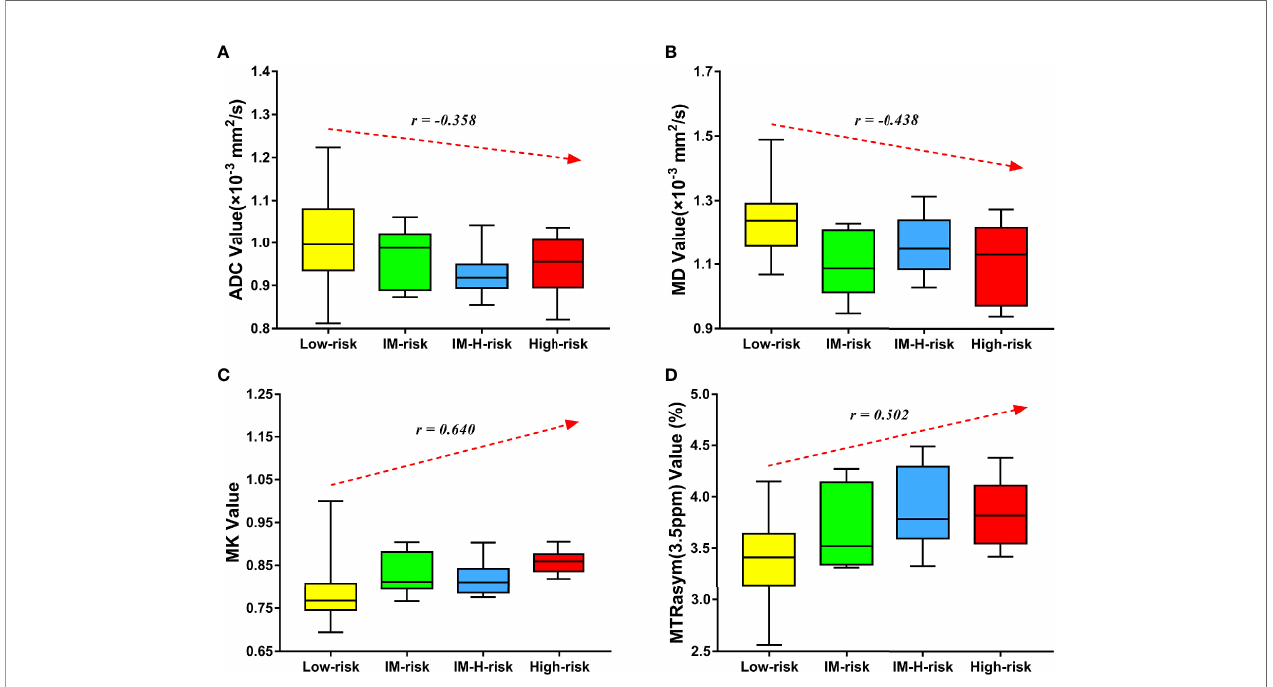
FIGURE 4 | Correlation of various parameters with risk strati fi cation ( LM , intermediate; LM-H , intermediate-high). The apparent diffusion coef fi cient (ADC) (A) and mean diffusivity (MD) (B) were mildly negatively correlated with risk strati fi cation ( r = − 0.358 and − 0.438, respectively). The mean kurtosis (MK) (C) and magnetization transfer ratio asymmetry (MTRasym, at 3.5 ppm) (D) were moderately positively correlated with risk strati fi cation ( r = 0.640 and 0.502,